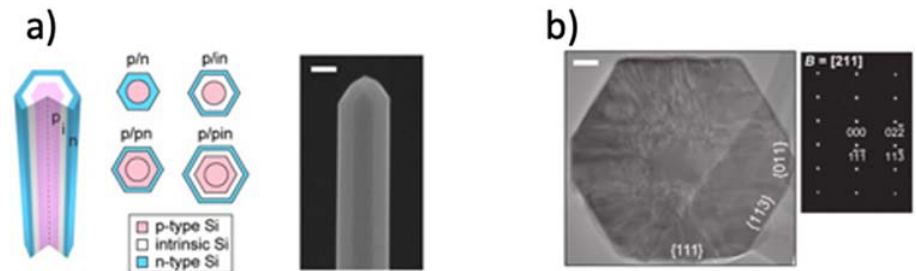
Figure 2. Three-dimensional schematic of a core/shell NW and cross-sectional schematics of four core/shell diode geometries, and SEM image of an as-grown, core/shell p/in Si NW, scale bar = 100 nm ( a ), and TEM image of a NW cross-section showing a core surrounded by crystalline shell, scale bar = 50 nm ( b ). Reprinted with permission from reference [73].